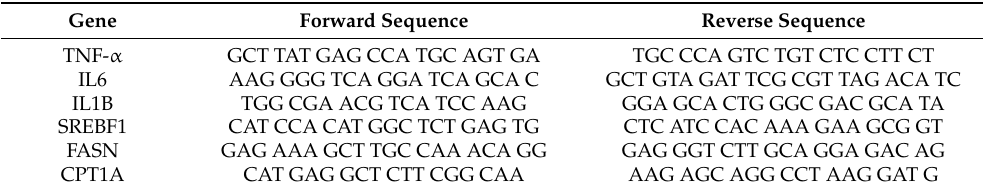
Table 1. Primers for